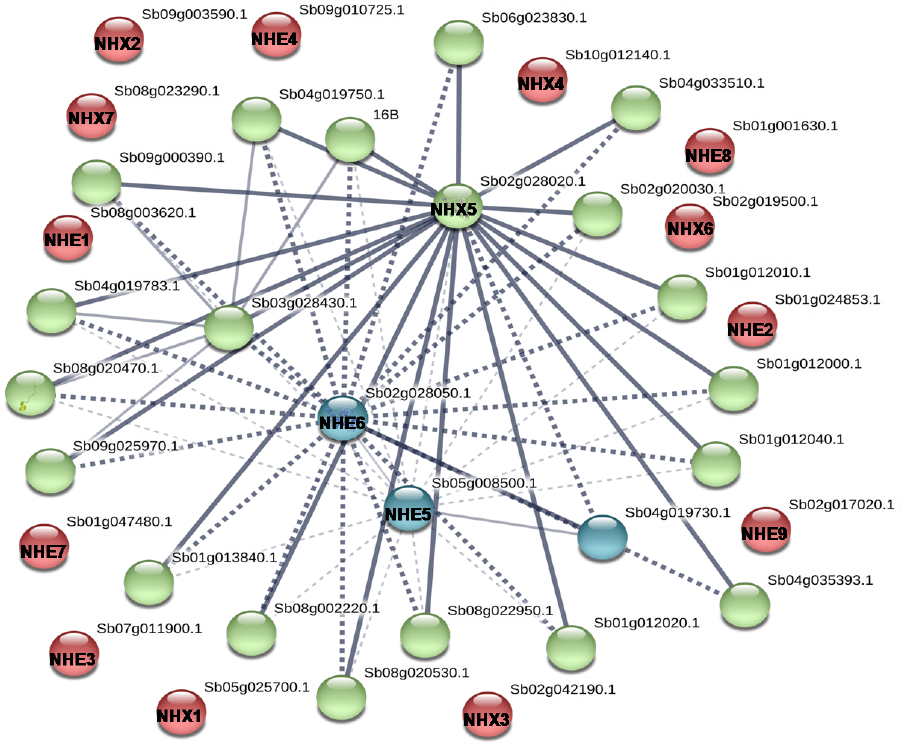
Figure 6. String analysis of SbNHX/NHE interacting proteins. All the SbNHX/NHE transporters are represented in bold.